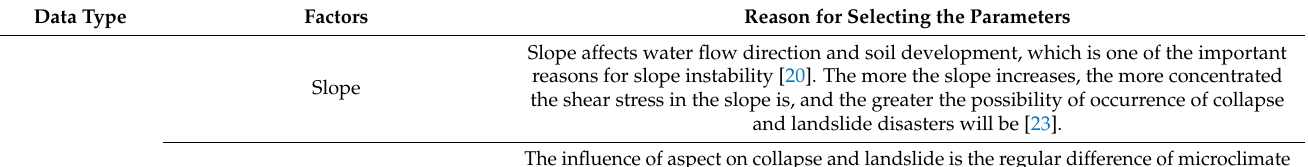
Table 2. Reasons for the selection of environmental